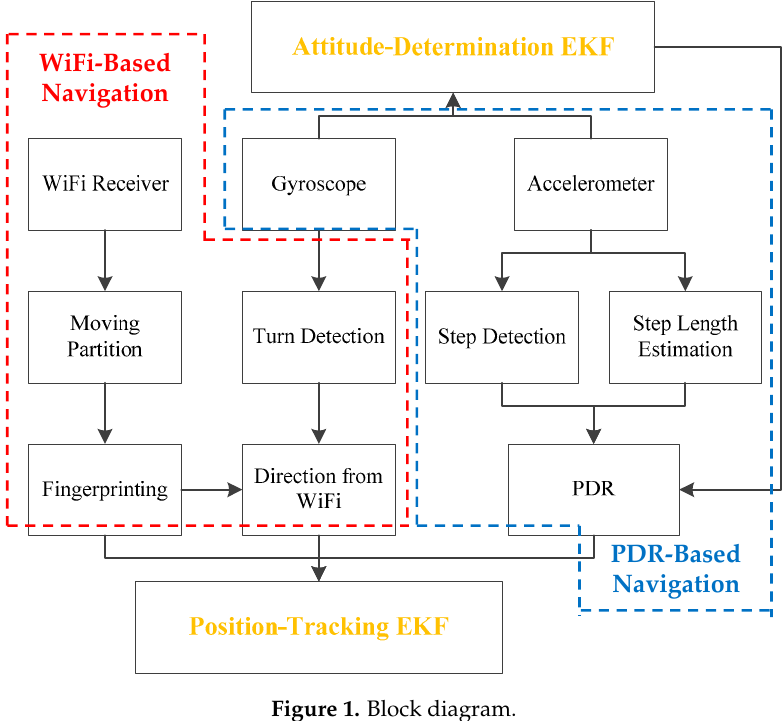
Figure 1. Block Figure 1. Block diagram.